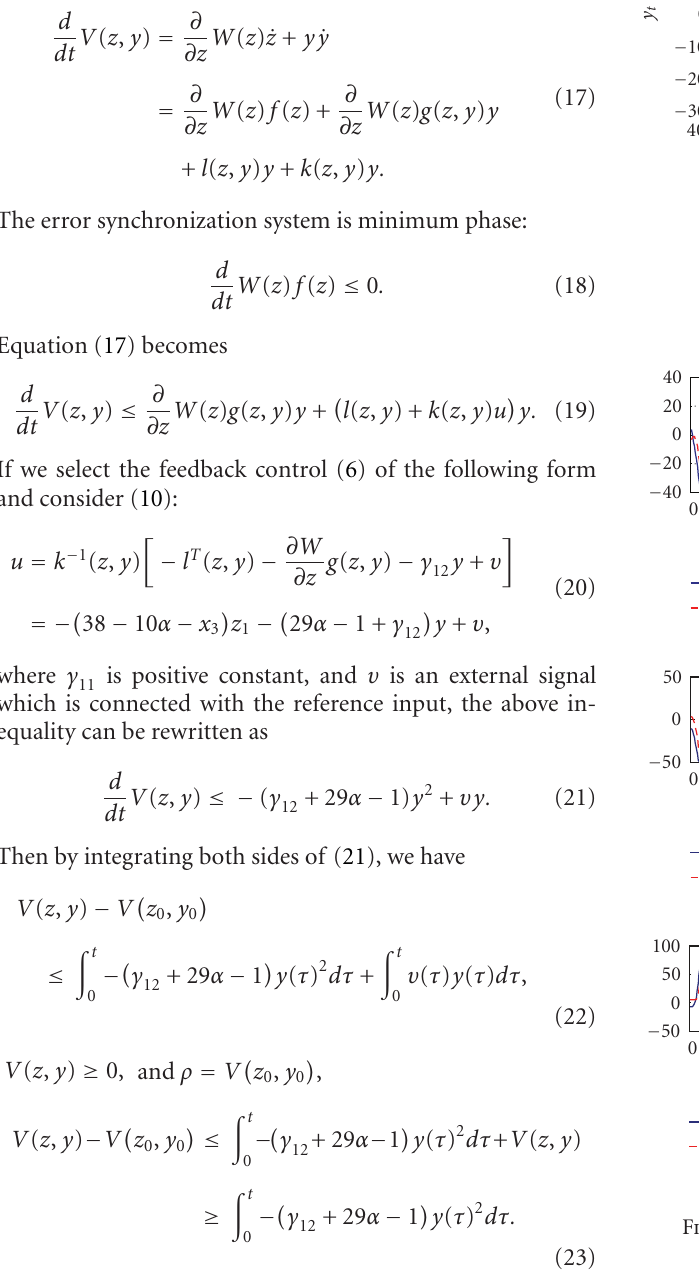
u = − (30 − x 3 ) e 1 − 33 . 2 e 2